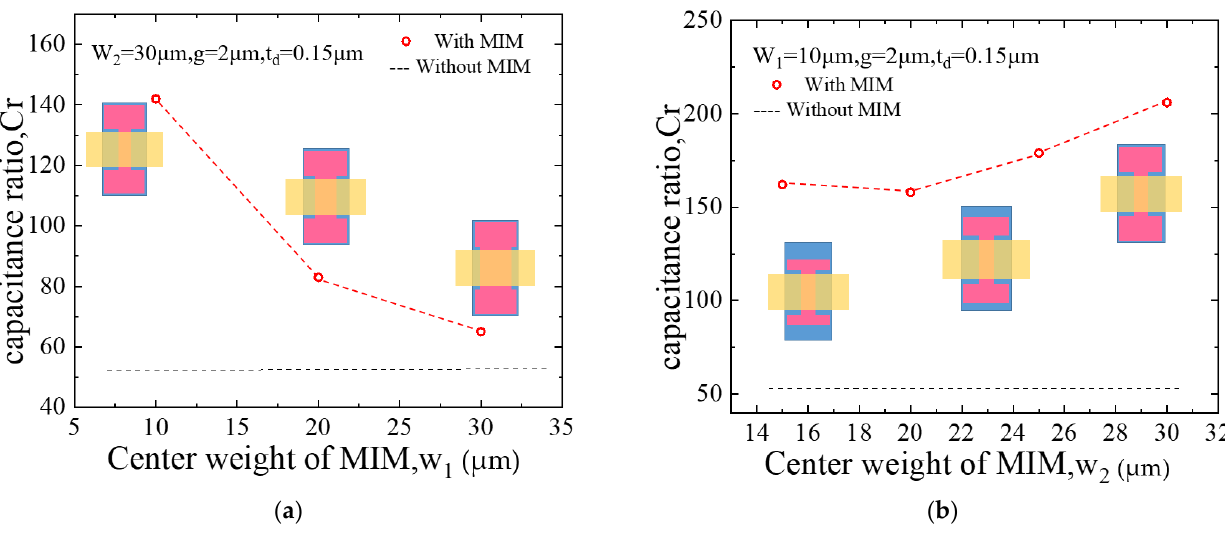
Figure 4. C r with and without MIM. ( a ) the relationship between C r and w 1 . ( b ) the relationship between C r and w 2 [16].